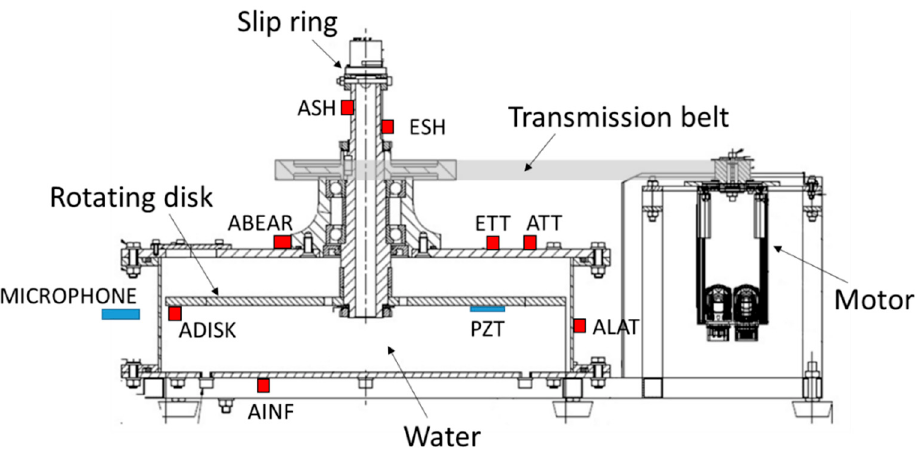
Figure 2. Sketch of the experimental test rig and the sensors installed. ADISK, accelerometer in the disk; AINF, accelerometer in the inferior cover; ABEAR, accelerometer in the bearing; ASH, accelerometer in the shaft; ESH, acoustic emission sensor in the shaft; ETT, acoustic emission sensor in the superior cover; ATT, accelerometer in the superior cover; ALAT, accelerometer in the lateral cover.